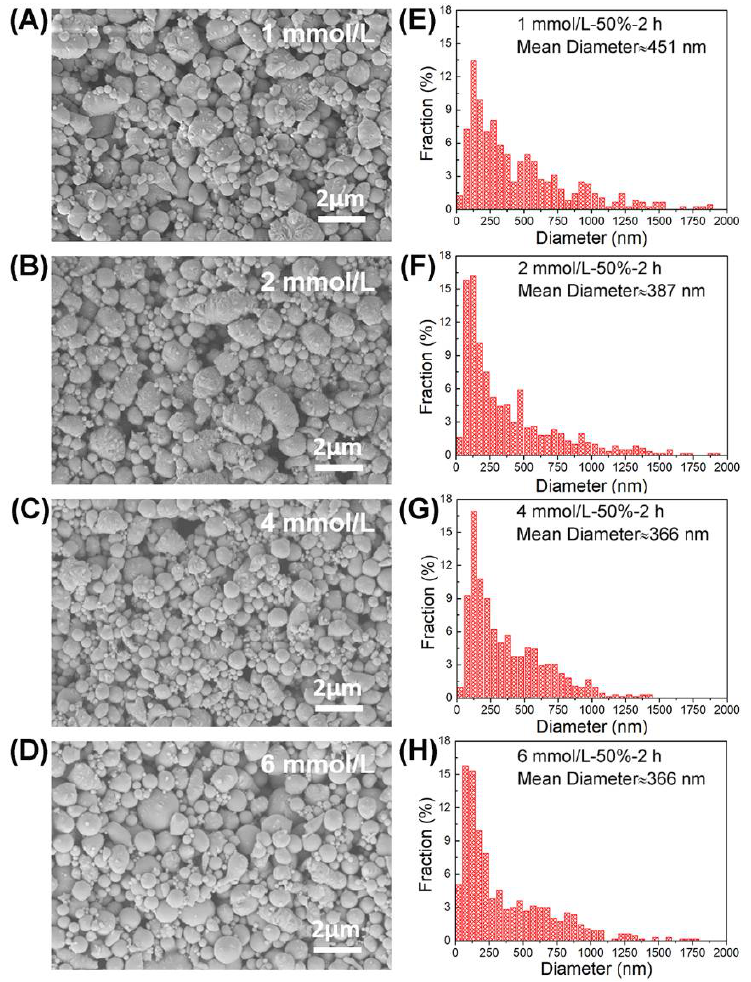
Figure 4. Morphology images and size distributions of eGaIn nanodroplets under different concentrations of surfactant: ( A , E ) 1 mmol/L, ( B , F ) 2 mmol/L, ( C , G ) 4 mmol/L, and ( D , H ) 6 mmol/L.